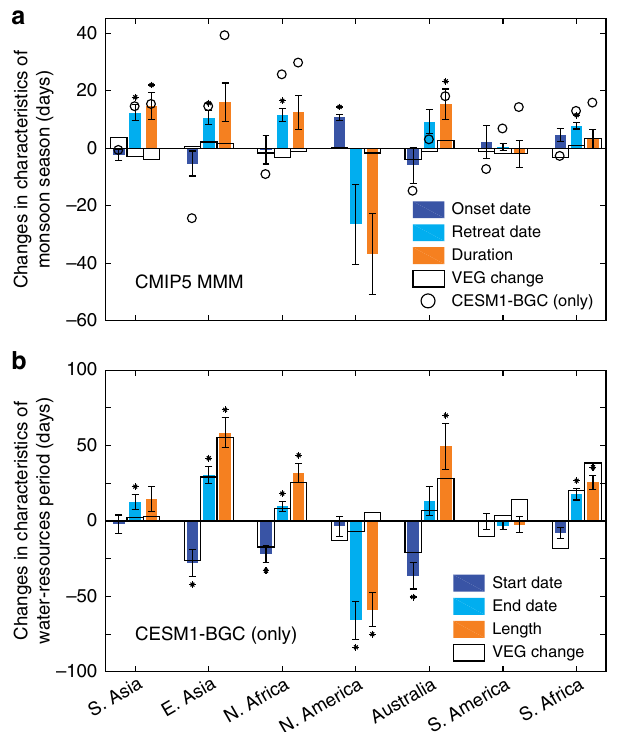
Fig. 5 Changes in seasonal characteristics of monsoon season and abundant water-resources period. a Monsoon season changes from the CMIP5 multi-model mean (MMM) for the seven regions as marked. Indices of seasonal characteristics are monsoon onset date, retreat date and monsoon season duration, presented for the all CO 2 -based forcings (ALL) simulations (colour bars). The error bars indicate standard errors of the mean of the three ESMs. Small black asterisks indicate if changes are signi fi cant for the three ESMs ( P < 0.05, t -test). The NorESM1-ME model is not included due to a lack of daily precipitation output in the CMIP5 archives. Black open rectangles indicate the changes associated with the physiological (VEG)-only forcing. Changes in monsoon season duration in ALL simulations from the CESM1-BGC only model are also presented (open circles). The changes in North America from CESM1-BGC are not available due to model dry bias (Supplementary Fig. 2d) and signi fi cant precipitation reductions at 4 × CO 2 (Supplementary Fig. 11d). b Abundant water resources period. Seasonal characteristic indices are start date, end date and length of abundant water resources period. Values in b are for only one model, CESM1-BGC, as no daily runoff output is available in the CMIP5 archives for the four ESMs (see Methods section). The error bars indicate standard errors based on interannual variability of runoff from CESM1-BGC only. Small black asterisks indicate that the change is signi fi cant in the CO 2 - enriched climate relative to the preindustrial period ( P < 0.05, t the last day dropping below a runoff threshold as our main proxy for water abundance changes. The baseline thresholds are calculated from only one model, CESM1-BGC 40 , because no daily runoff output is available in the CMIP5 archives for our four ESMs (please see Methods for validation of single-model use).